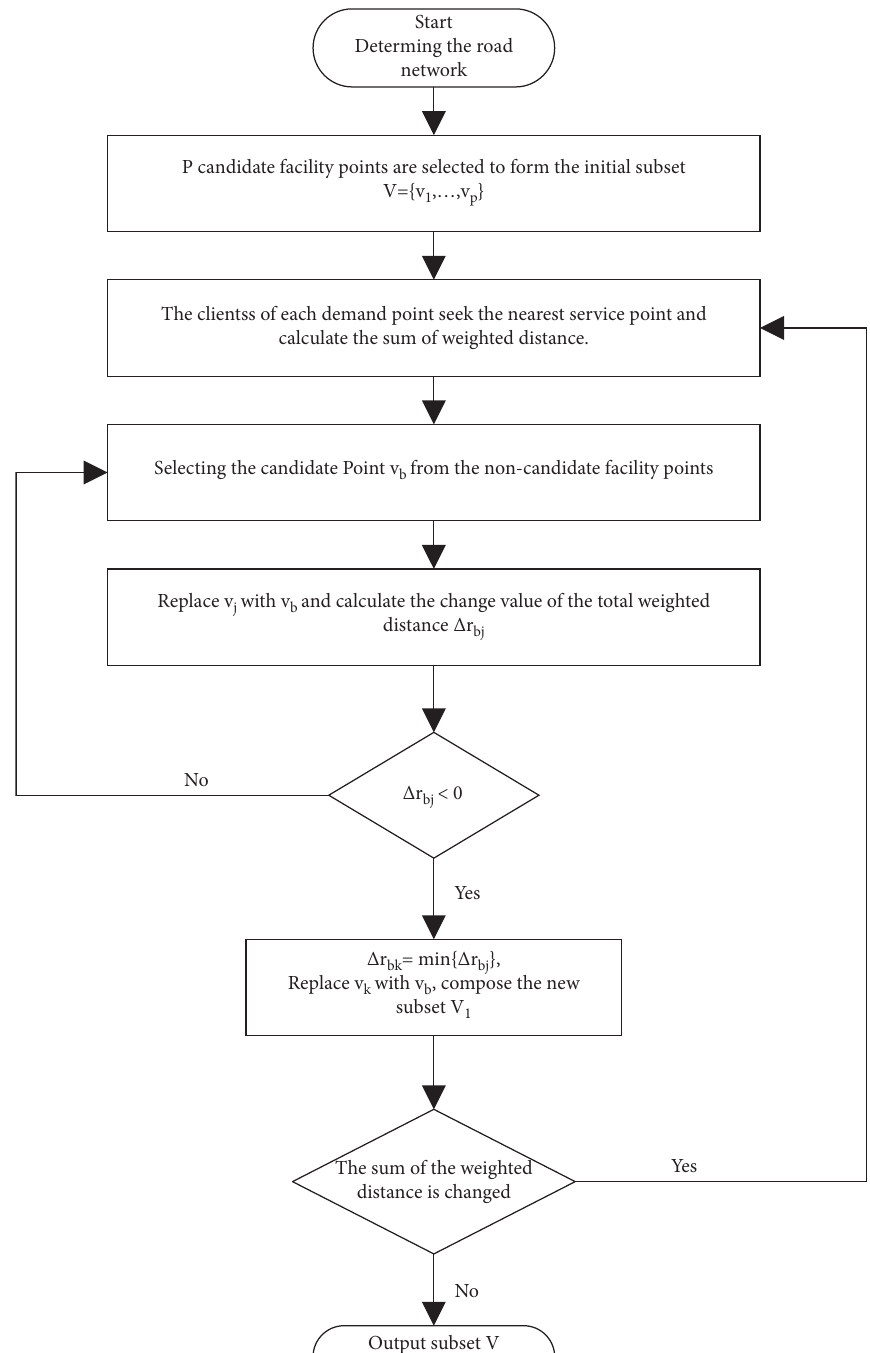
Figure 3: The flowchart of the Teitz–Bart